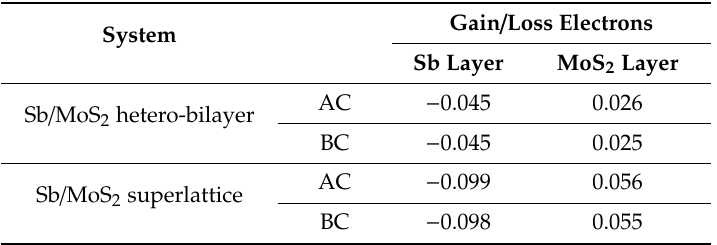
Table 2. Bader analysis for the